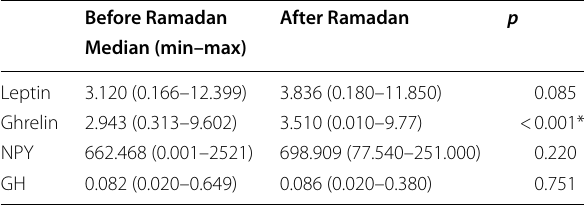
Wilcokson signed rank test was performed for the analysis of variables. NPY Neuropeptide-Y, GH growth hormone. All values except NPY were expressed as ng/mL. NPY value was expressed as ng/L. *Indicates significance, p <